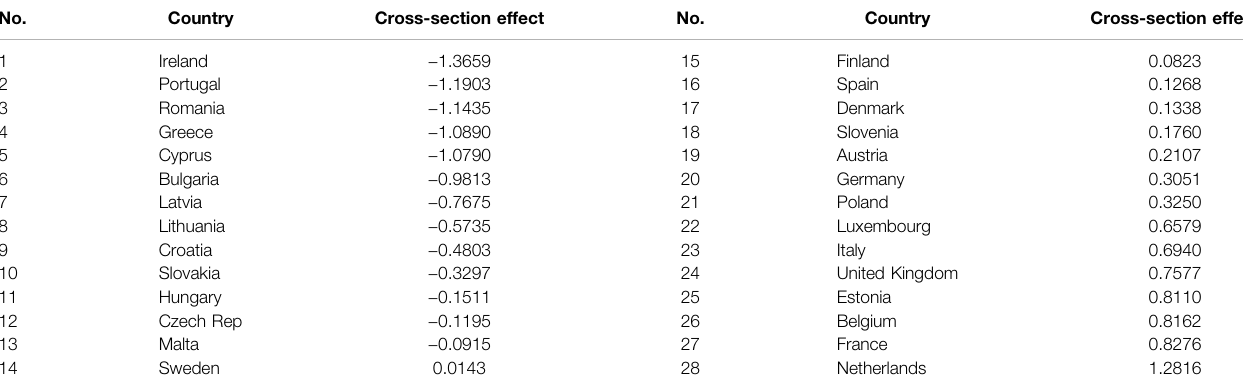
TABLE 6 | Cross-section effects ( α i ) for Fixed Effect model (sorted ascending). No.